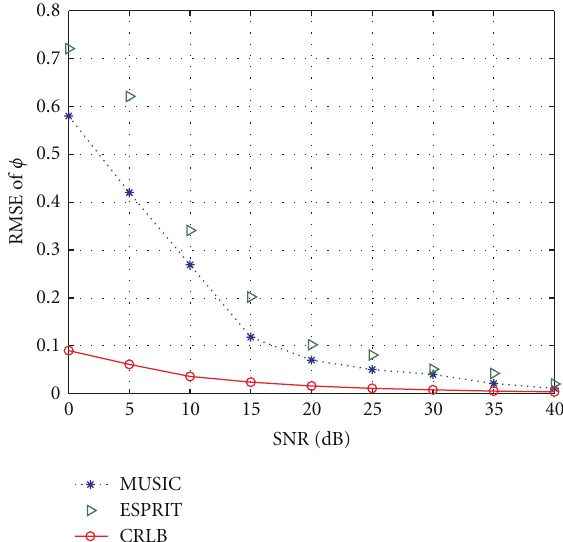
Figure 14: Performance comparison for the estimation of azimuth angle using MUSIC and ESPRIT algorithms for CCRA design of case